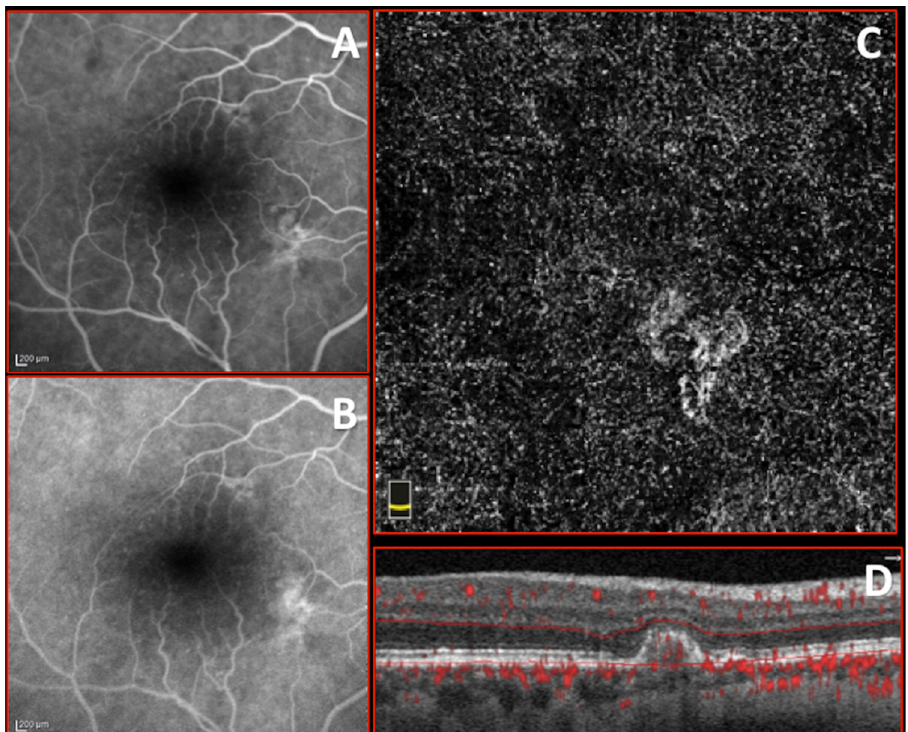
Figure 4. Imaging of treatment-naïve quiescent macular neovascularization (MNV). ( A , B ) Early and late stage of fluorescein angiography (FA) showing inhomogeneous small hyperfluorescence without leakage. ( C , D ) 3 × 3 optical coherence tomography angiography (OCTA) and corresponding structural OCT b scan of choriocapillary plexus showing circular, well defined, foveal-sparing treatment-naïve quiescent MNV with small loops.